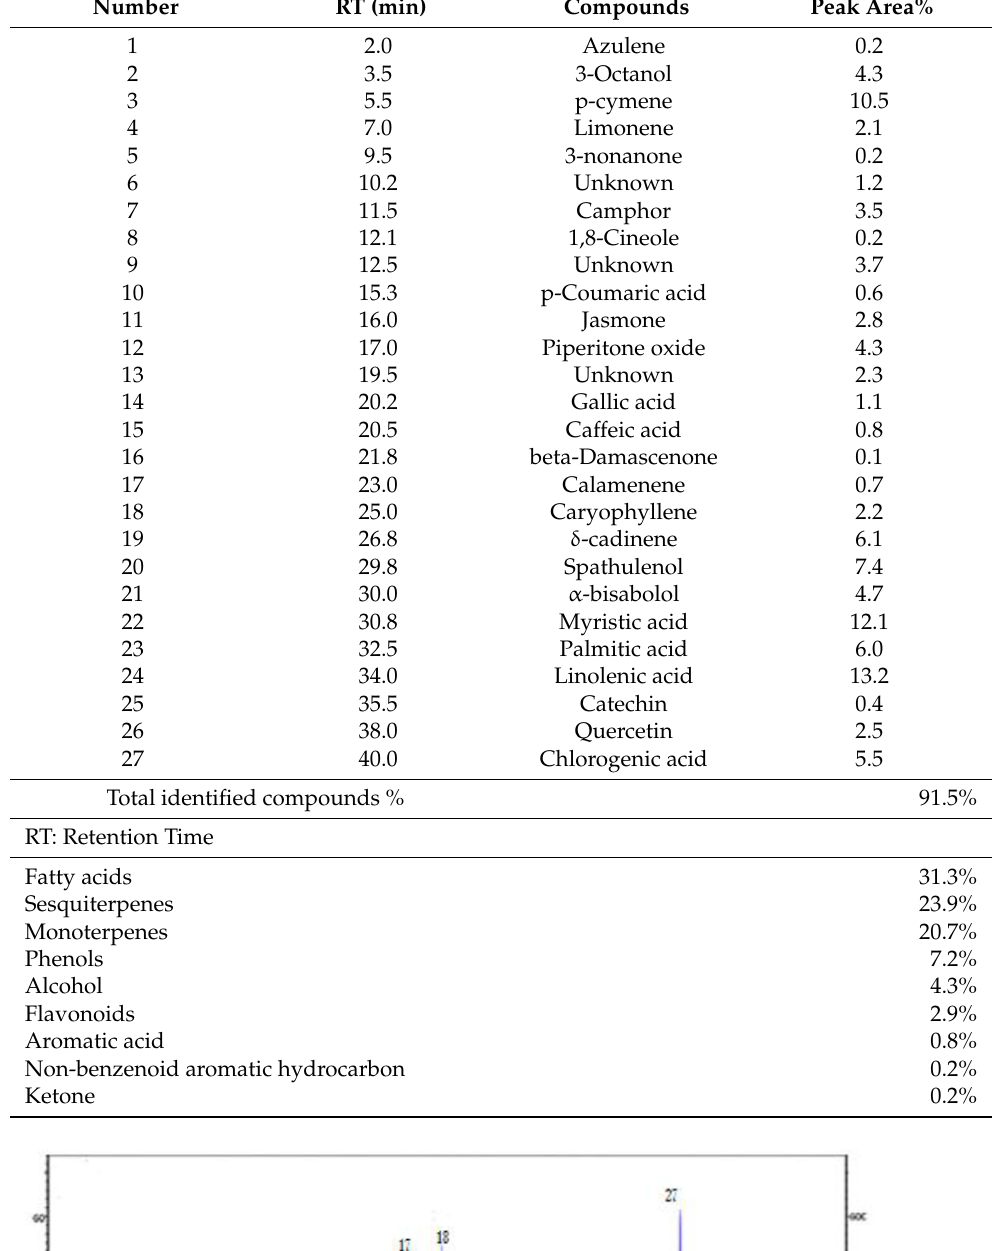
Table 1. Chemical composition of C. incana ethanolic extract.